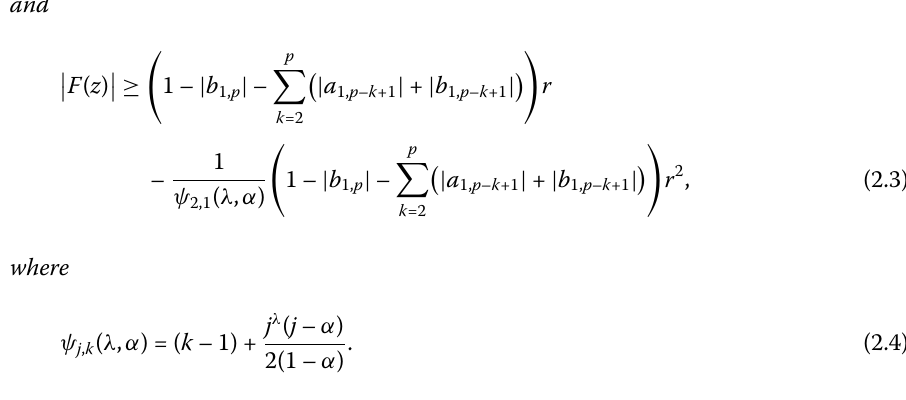
Figure 2 When F ( z ) is a 10-harmonic function